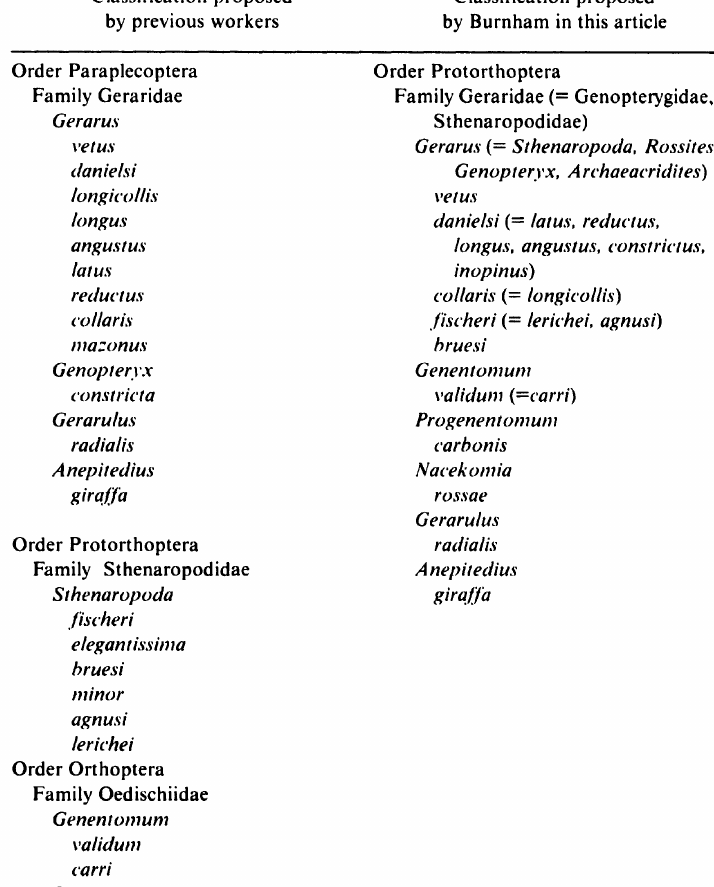
TABLE I. Past and Present Classifications of the Geraridae. Classification proposed by previous workers